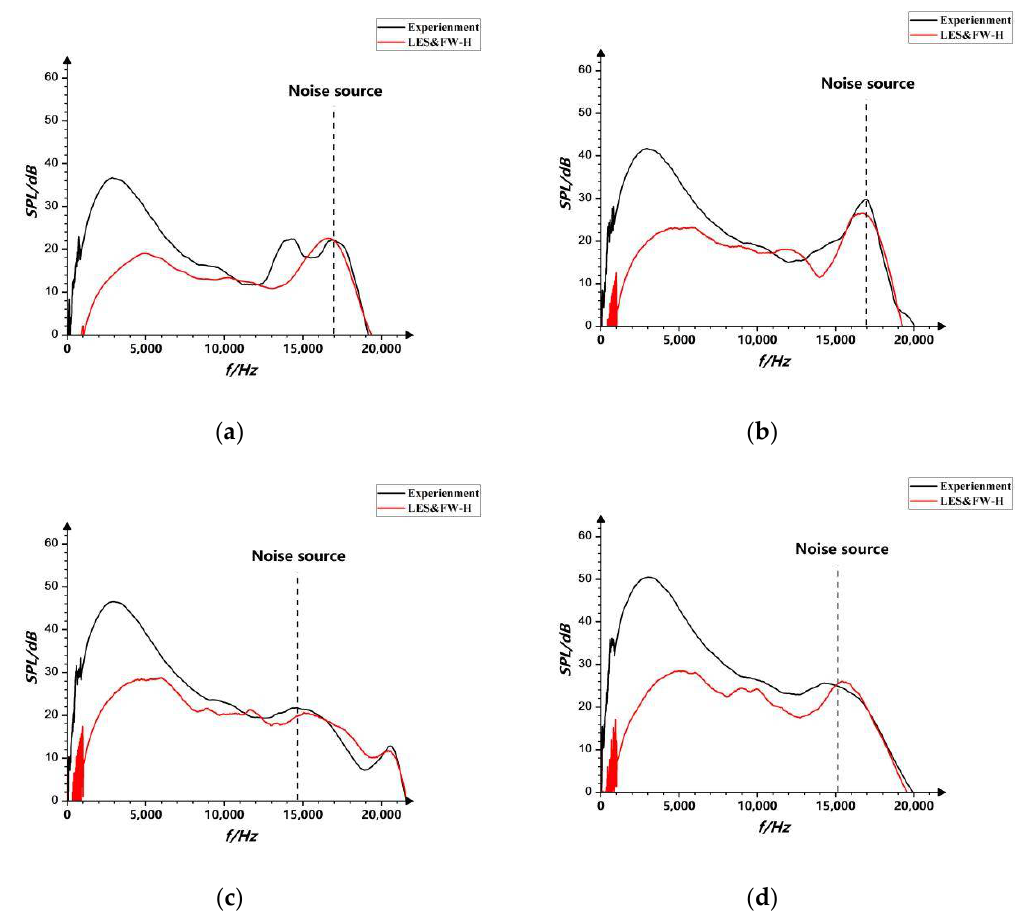
Figure 18. The wind angle 90°. ( a ) Wind speed 25 m/s; ( b ) Wind speed 30 m/s; ( c ) Wind speed 35 m/s; ( d ) Wind speed 40 m/s.